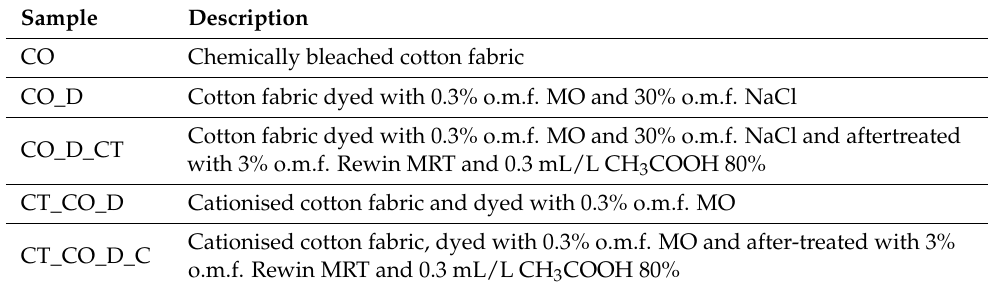
Table 1. Description of samples used in the